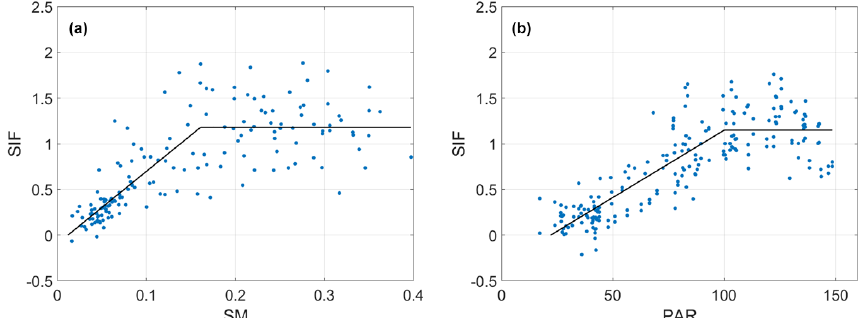
Figure 5. Example SIF relationships with water and light with model estimation from Fig. 4 demonstrated. Scatter plot of (a) sun-induced chlorophyll fluorescence (SIF (mWm − 2 nm − 1 sr − 1 )) and soil moisture (SM (m 3 m − 3 )) data and (b) SIF and photosynthetically active radiation (PAR (Wm − 2 )) data for the primary growing season and for a single 72 × 72km 2 pixel located in (a) the Sahel region (Mali, lati- tude/longitude: 13.68 ◦ N/6.35 ◦ W) and (b) Spain (Zamora, latitude/longitude: 41.25 ◦ N/5.60 ◦ W). Data are fitted with a two-regime